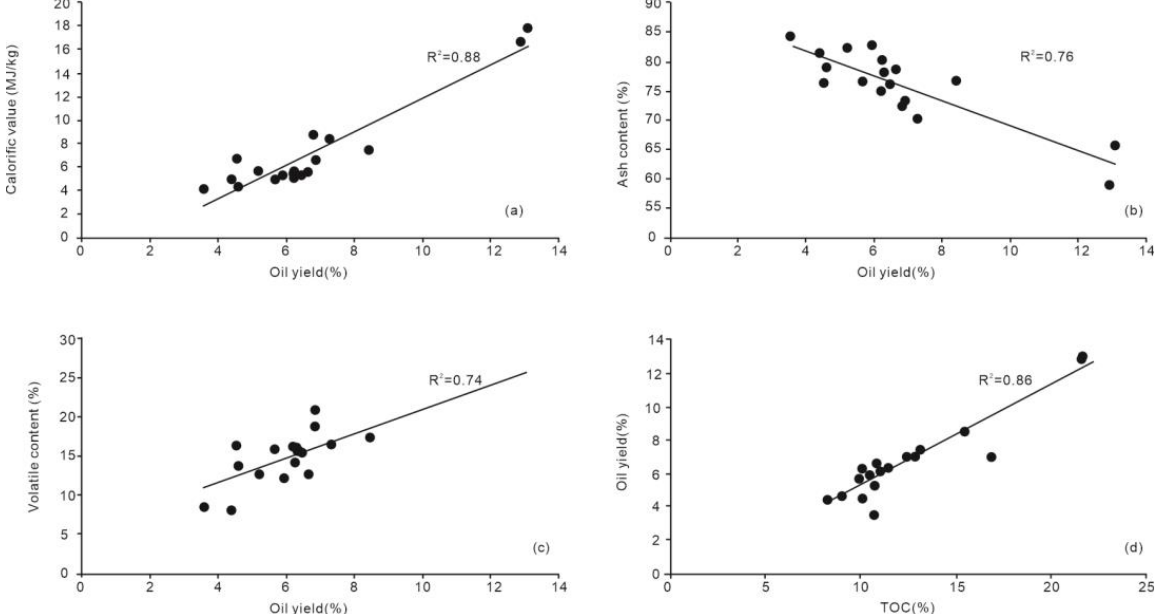
Figure 5. Series correlation diagram: ( a ) Oil yield – calorific value; ( b ) oil yield – ash content; ( c ) oil yield – volatile content; ( d ) oil yield – TOC.